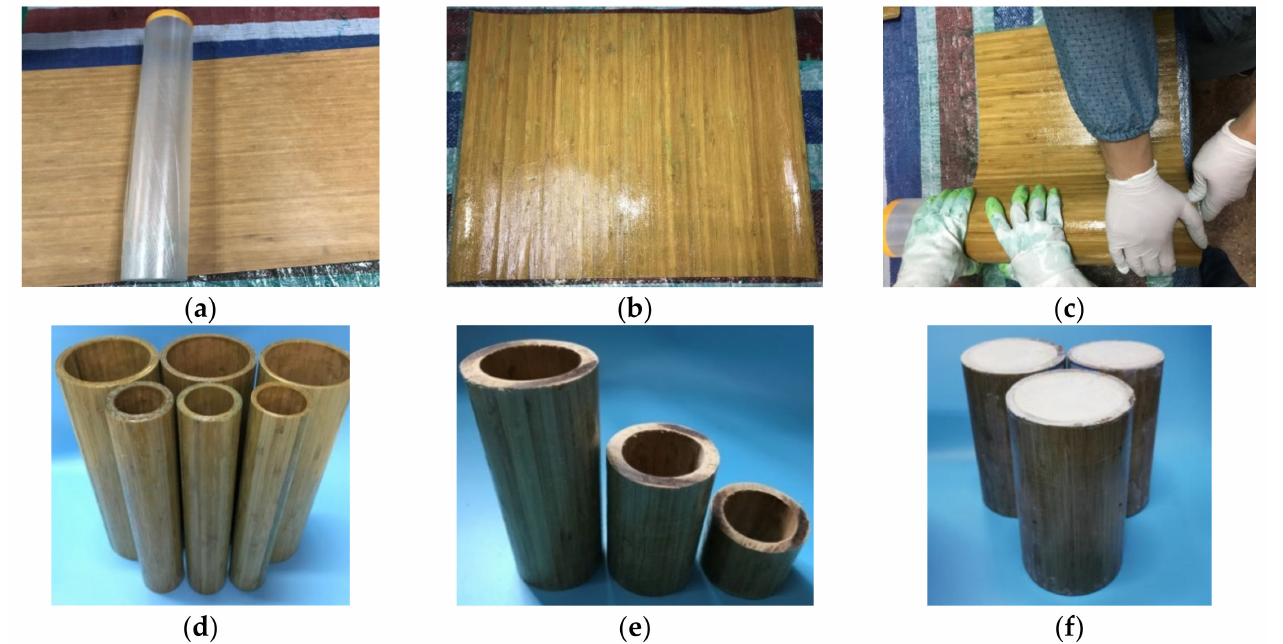
Figure 2. Manufacturing process of specimens. ( a ) Preparation of raw materials; ( b ) soakage of epoxy resin; ( c ) winding of bamboo slice; ( d ) demolding and curing; ( e ) cutting and polishing; ( f ) foam